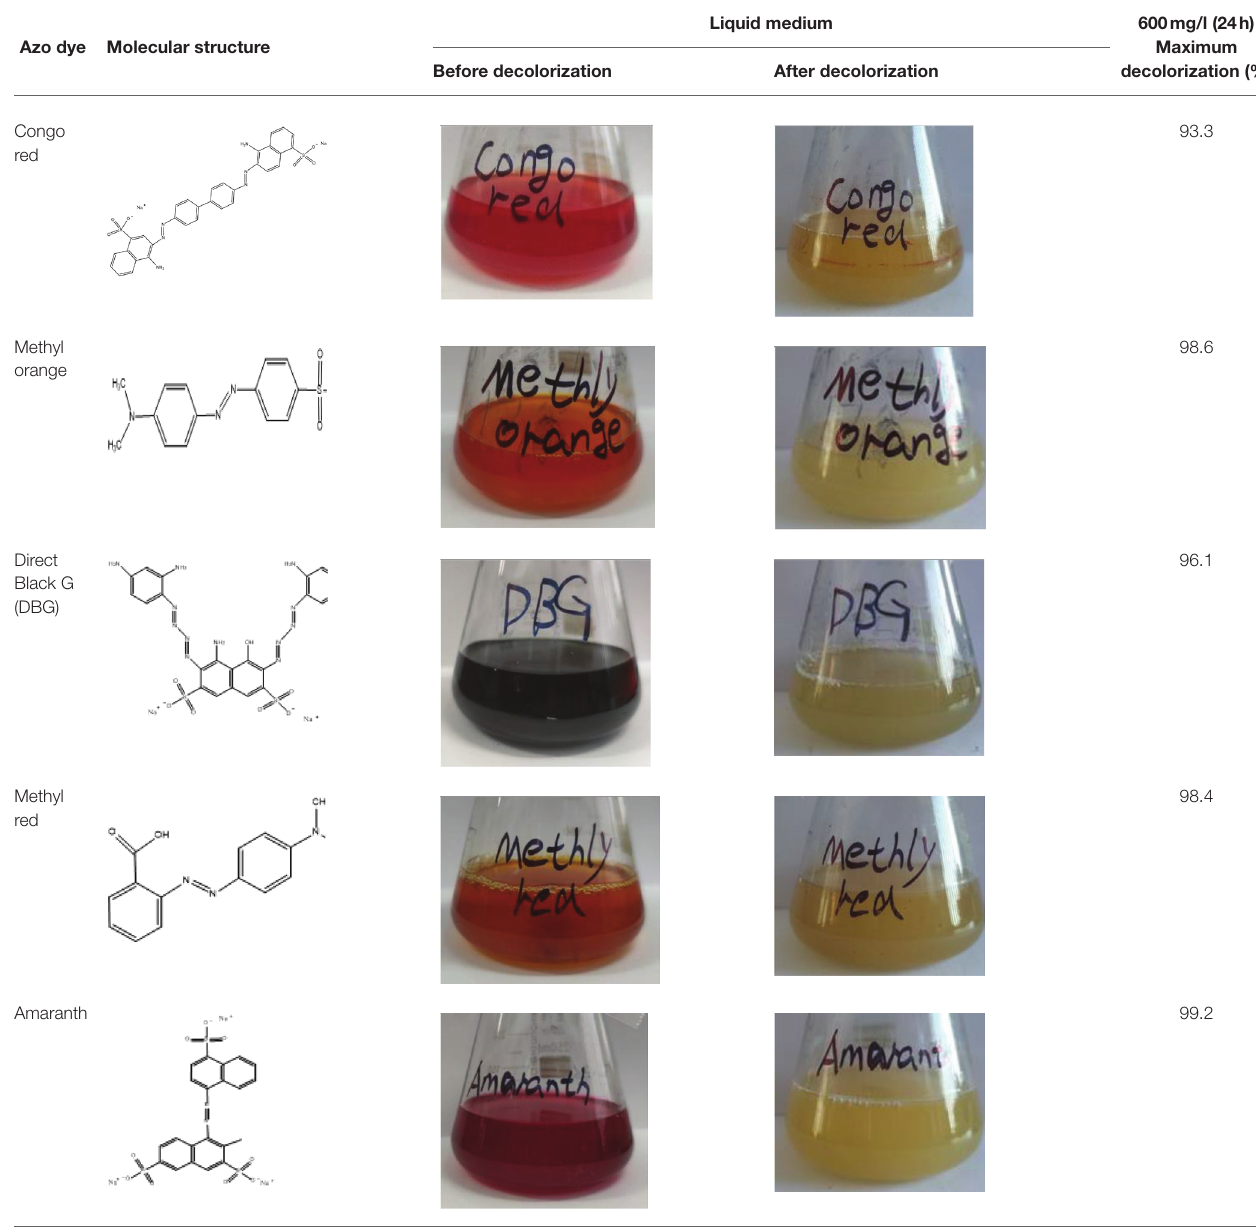
Azo dye Molecular